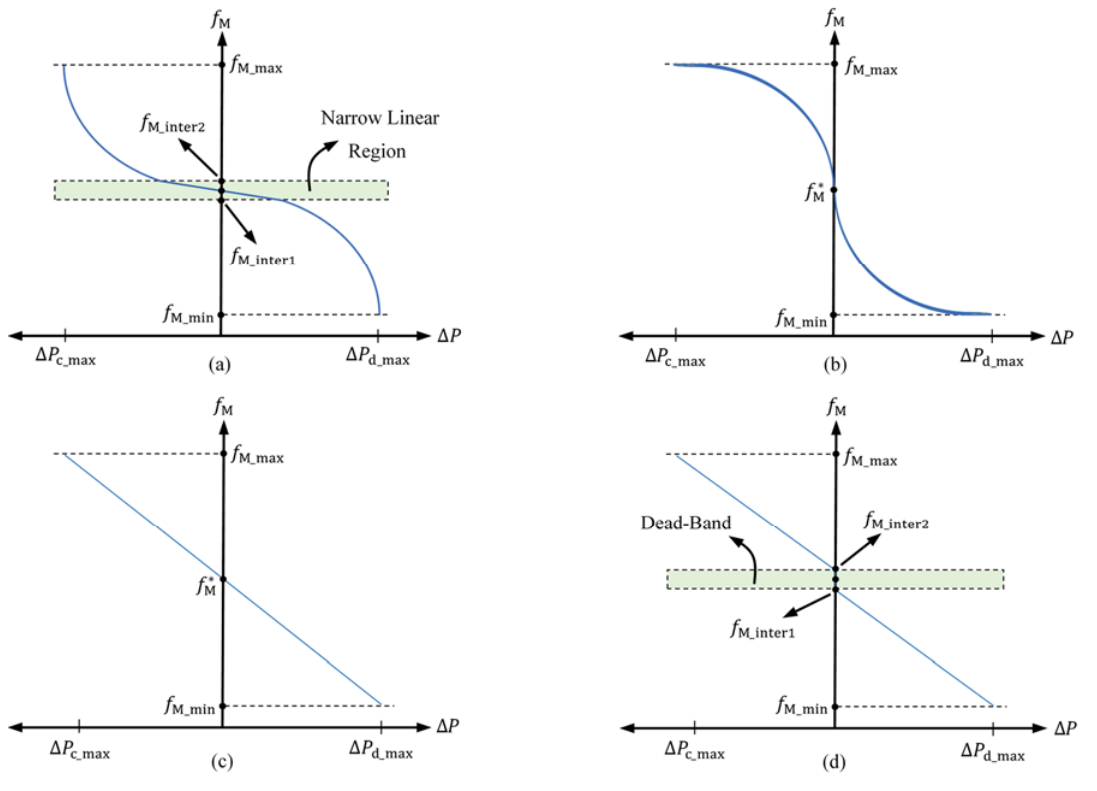
Figure 1. Piecewise linear-elliptic (PLE) active power-frequency ( P-f ) characteristic versus other P-f characteristics for the dynamic-response enhancement in islanded microgrids: ( a ) PLE; ( b ) nonlinear; ( c ) linear; and ( d ) linear with a dead band.